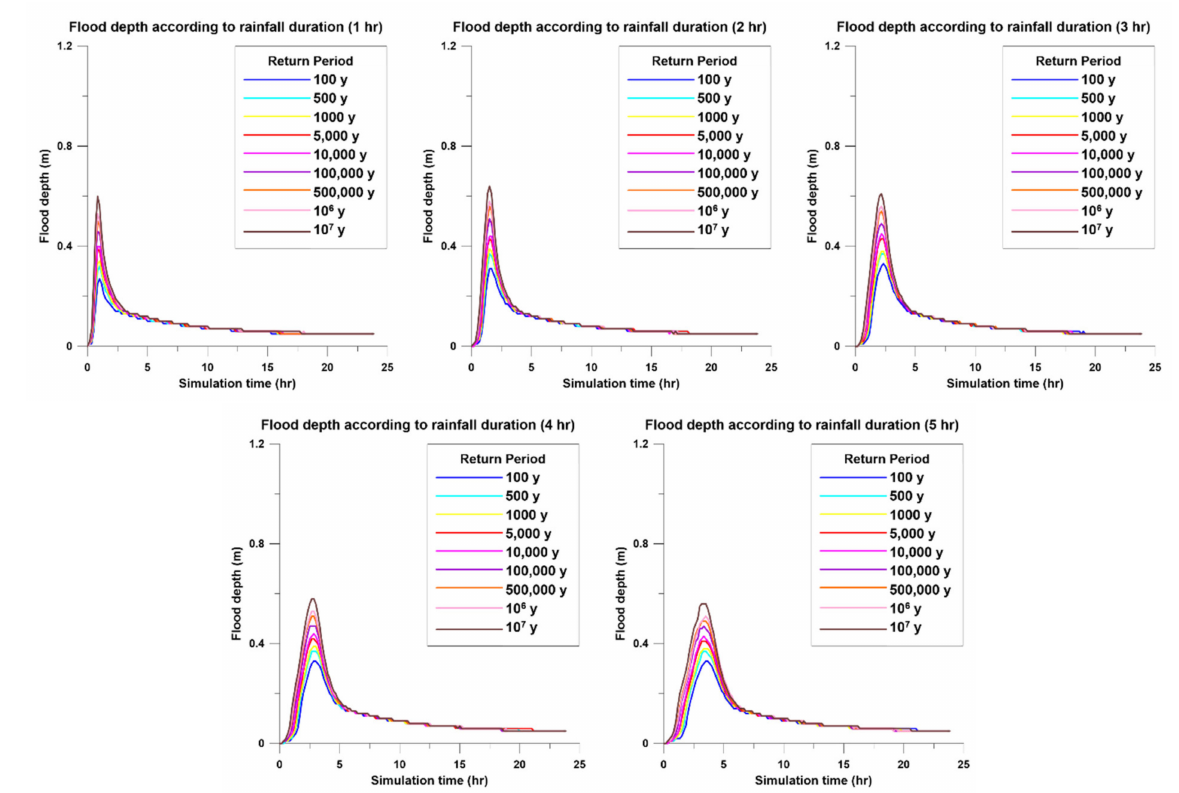
Figure 8. Inflow boundary conditions for grid no. 22821 (control building, NPP 4).